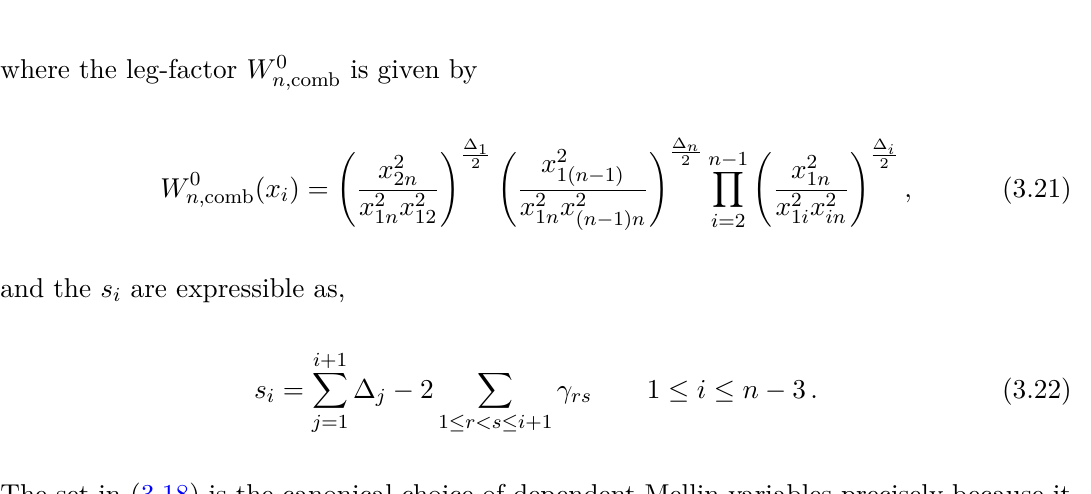
Figure 3. Auxiliary momenta and Mandelstam variable assignments: graphical representation of n -point conformal blocks in the comb and channel from figure 1a with auxiliary momenta and Mandelstam variables